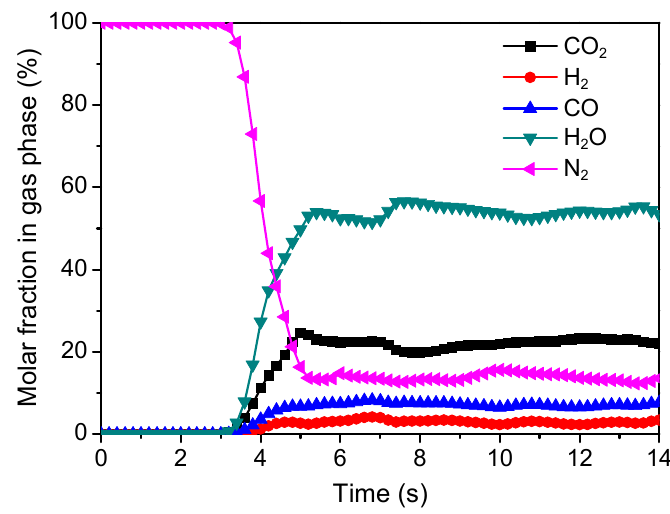
Figure 4. Variations of the gas molar fractions with time at the fuel reactor outlet.